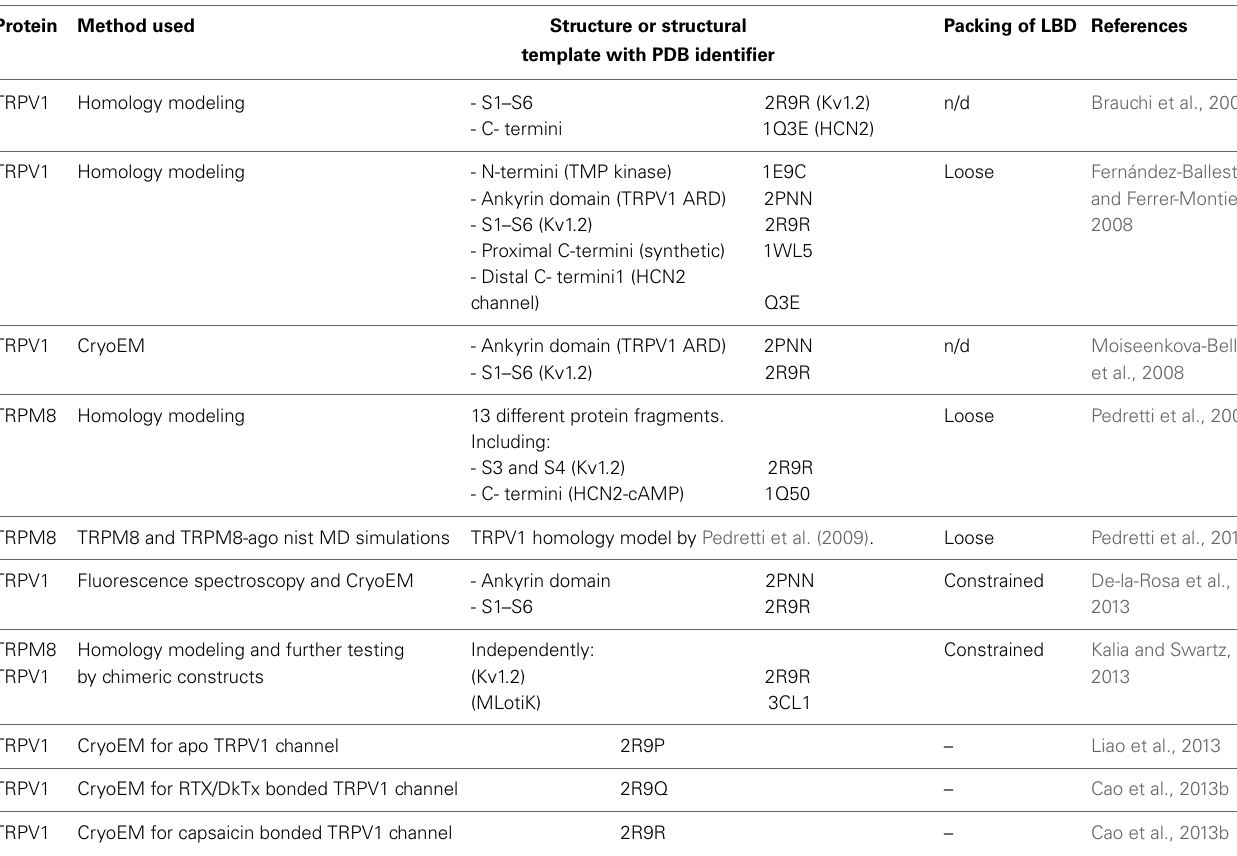
Table 1 | Templates used for homology modeling of TRPs and the packing of LBD of TRPV1 and TRPM8 channels. Protein Method